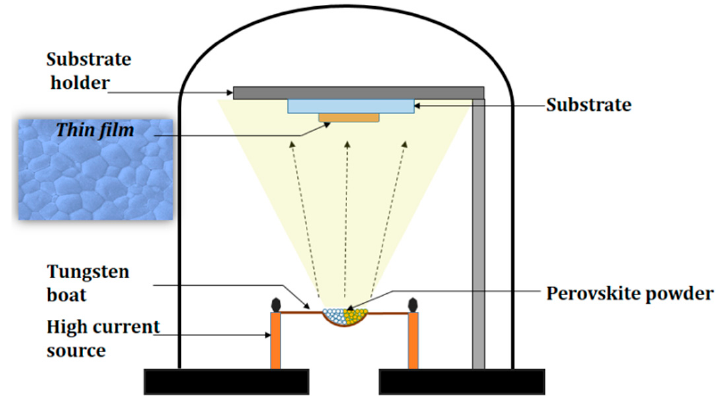
Figure 1. Schematic diagram of the thermal evaporation setup [10].